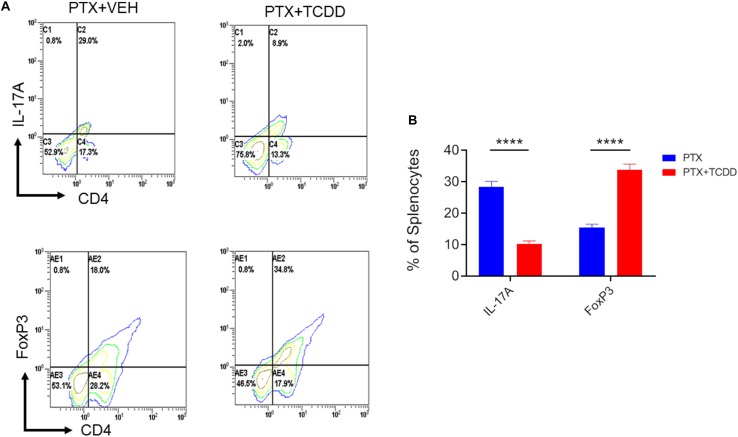
TCDD promotes Treg while inhibiting Th17 induction. Mice were immunized with PTX and injected with TCDD as described in the legend of Figure 1. Splenocytes were double-stained for CD4 and FoxP3 or CD4 and IL-17 markers and analyzed using flow cytometry. Panel A shows a representative experiment while data from multiple experiments is plotted in panel B, showing reciprocal regulation of Th17 vs. Tregs between the two groups. Statistical analysis was performed using Student’s t-test with the differences between the two groups showing ****p < 0.0001.